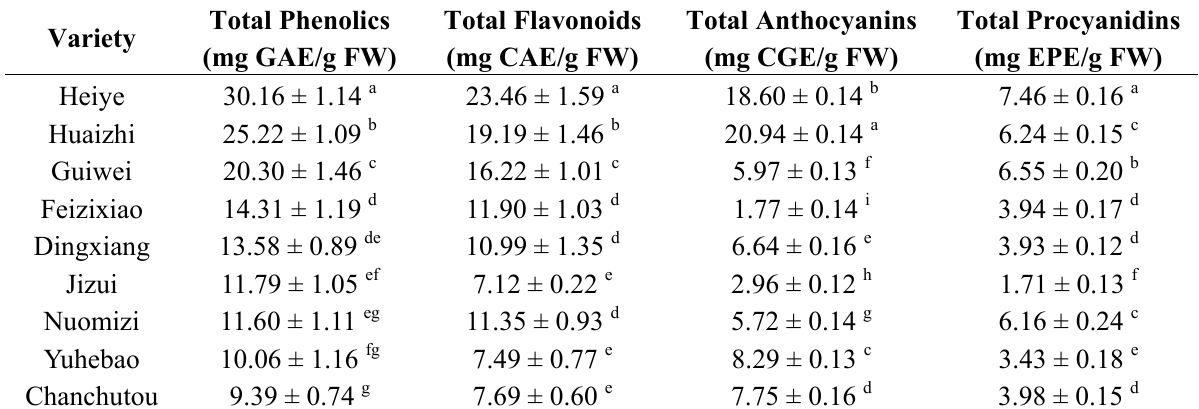
Table 1. Total phenolic, flavonoid, anthocyanin, and procyanidin contents in litchi pericarp of nine